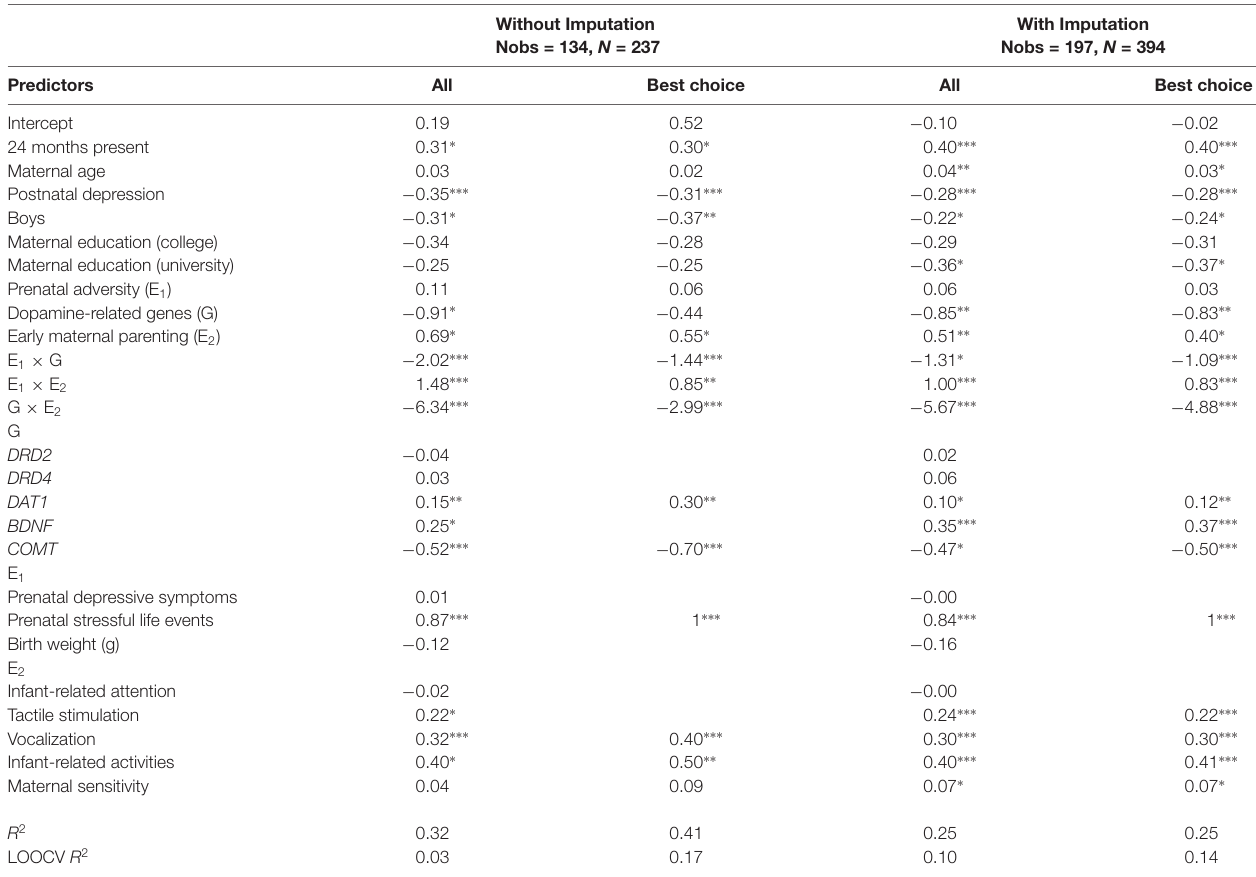
TABLE 4 | Predicting toddler attentional competence at 18 and 24 months based on two-way interactions between prenatal adversity, dopamine-related genes, and early maternal parenting behaviors with/without imputation and with/without variable selection. Without